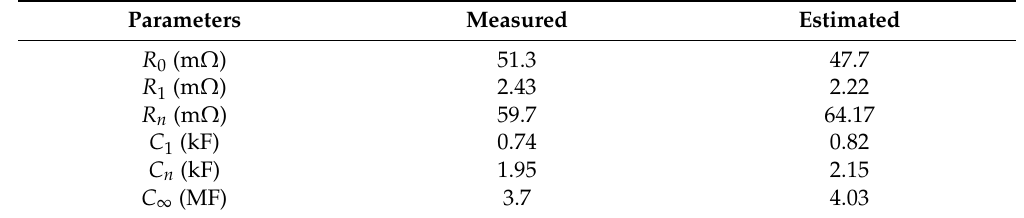
Table 12. Results of Case